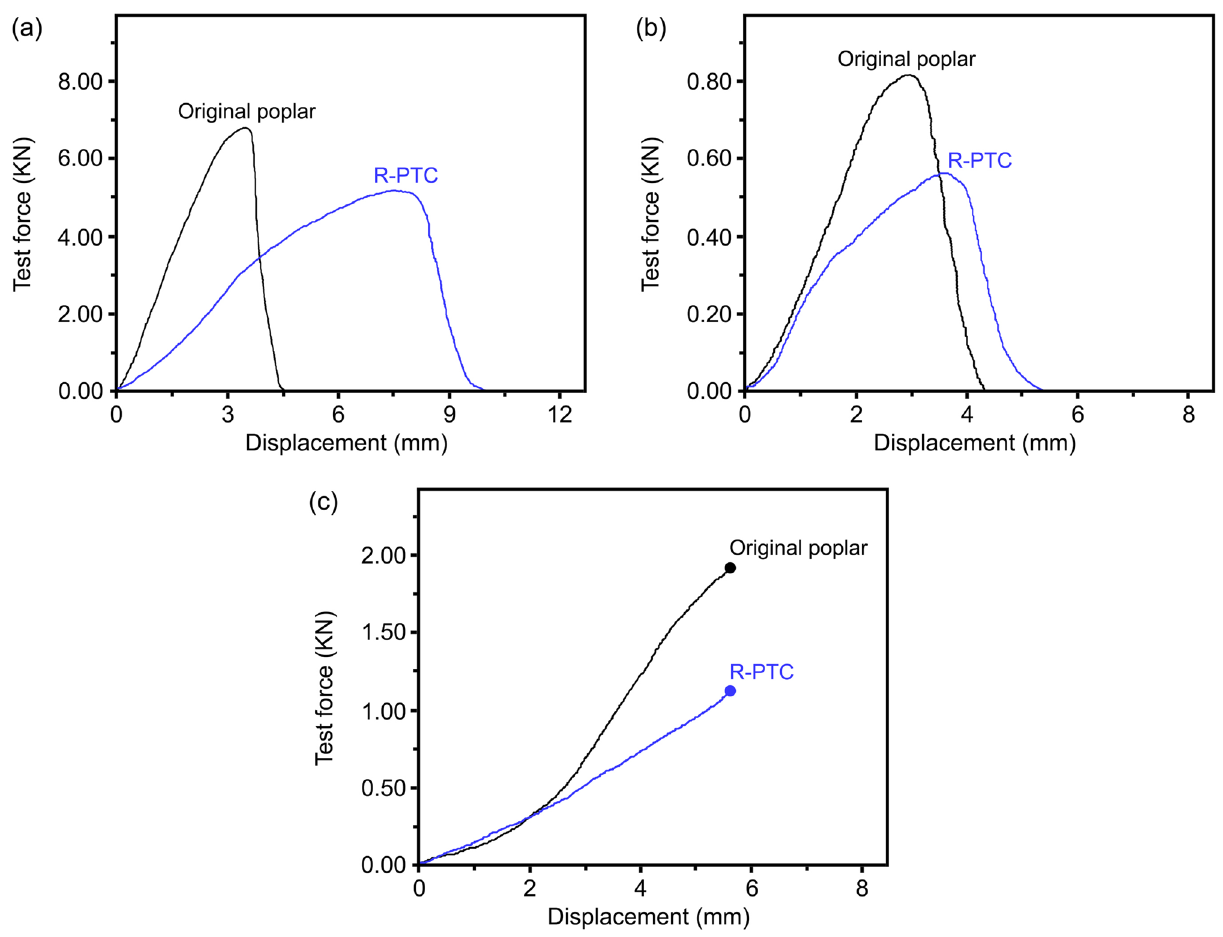
Figure 6. ( a ) Longitudinal compressive strength. ( b ) Longitudinal tensile strength. ( c ) Radial